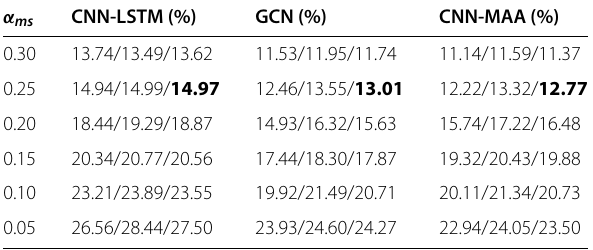
Spectrum Smoothing attack( UA / WA / ACC